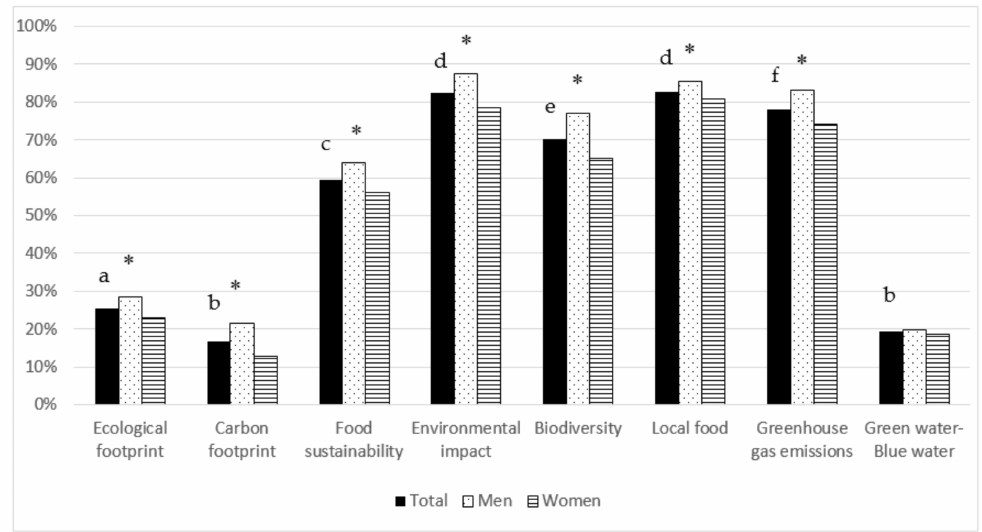
Figure 1. Percentage of Spanish adult population that stated knowing the meaning of di ff erent terms related with food sustainability, by gender. Di ff erent letter superscripts denote statistical di ff erences ( p ≤ 0.05) between percentages of people knowing each terms; * shows statistical di ff erences ( p ≤ 0.001) between men and women. Sample size: 882 men and 1170 women.